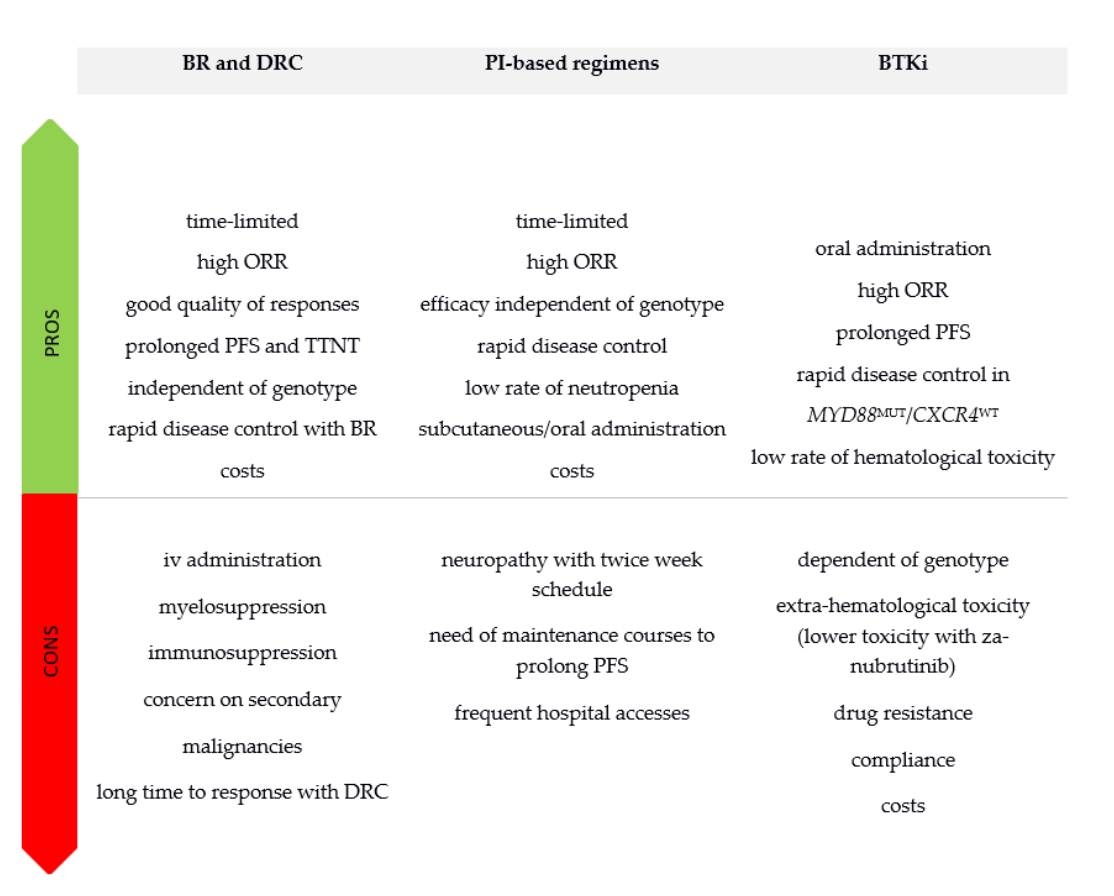
Figure 1. Pros and cons of treatment options in Waldenström Macroglobulinemia. BR: benda-